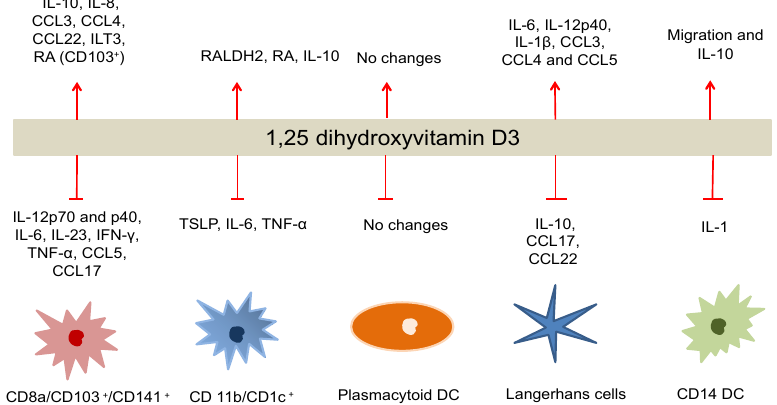
D on the expression of interleukins, cytokines and 2 3